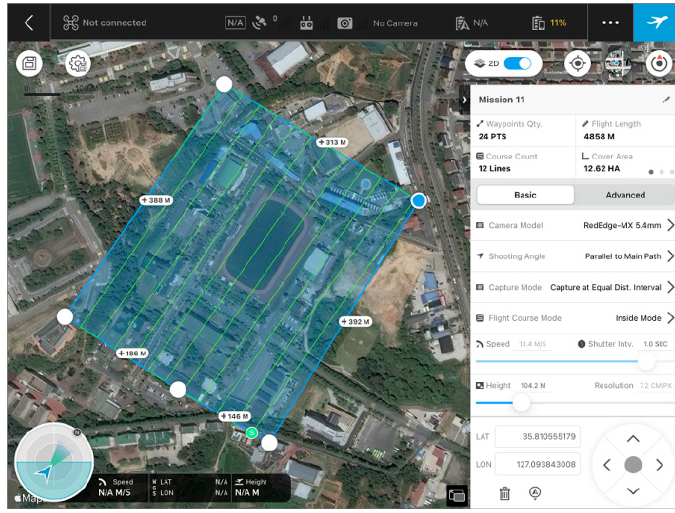
Figure 4. UAV flight planning using the DJI GS Pro S/W. Table 1. Specifications of the Micasense RedEdge MX.